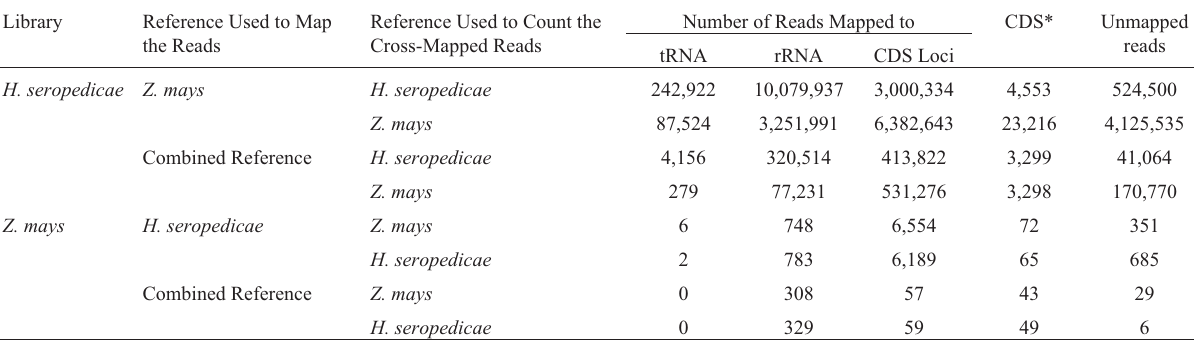
Table 3 - Comparison of the number of reads incorrectly mapped due to cross-mapping, with the mapping parameters of 0.8 of minimum length fraction and0.8ofminimumsimilarityfraction.Readsthatincorrectlymappedtothereferencegenomewerecountedusingtheannotatedgenomeindicatedonthe table.Theunmappedreadsarearesultofthecountingparametersthateliminatereadsthatmappedinmorethanfivelociandoftheintergenicregions. Library Reference Used to Map Reference Used to Count the Number of Reads Mapped the Reads Cross-Mapped Reads